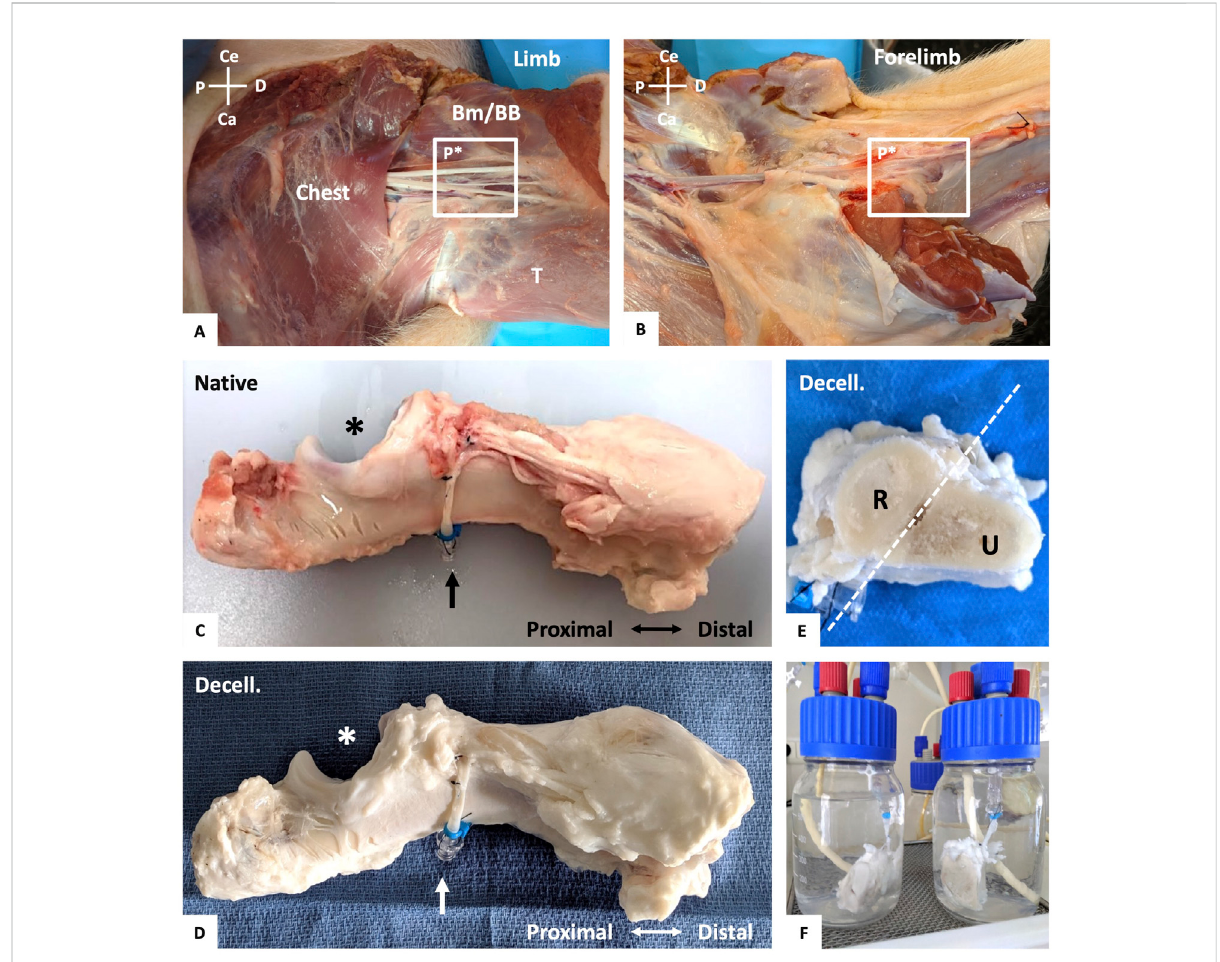
FIGURE 1 Vascularized forelimb bone graft harvesting and perfusion decellularization process. (A, B) : Dissection of the left brachial vascular pedicle (P*) between the chest muscles, triceps (T), biceps brachii (BB) and brachialis muscle (Bm) with identi fi cation of the vascular pedicle (A) . Transection of thelimbandforelimbmusclesandidenti fi cationoftheinter-osseousforamenanditsvascularpedicle(P*) (B) .For (A) and (B) ,bothareanteriorviews with: Ce = cephalic, Ca = caudal, P = proximal, and D = distal. (C) Native vascularized forelimb bone graft following muscle excision, with its preserved vascular pedicle (artery and vein, black arrow) and ulnar notch (*). (D) Final aspect of decellularized forelimb bone graft after perfusion decellularization process with its preserved vascular pedicle (white arrow). (E) Axial section of the decellularized forelimb (C) with the radius (R) and ulna (U). (F) Example of potentially segmented decellularized bone graft in perfusion